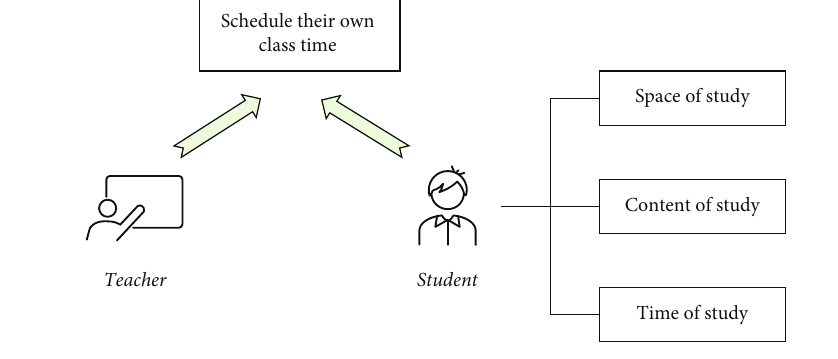
Figure 4: Task of teacher and student.